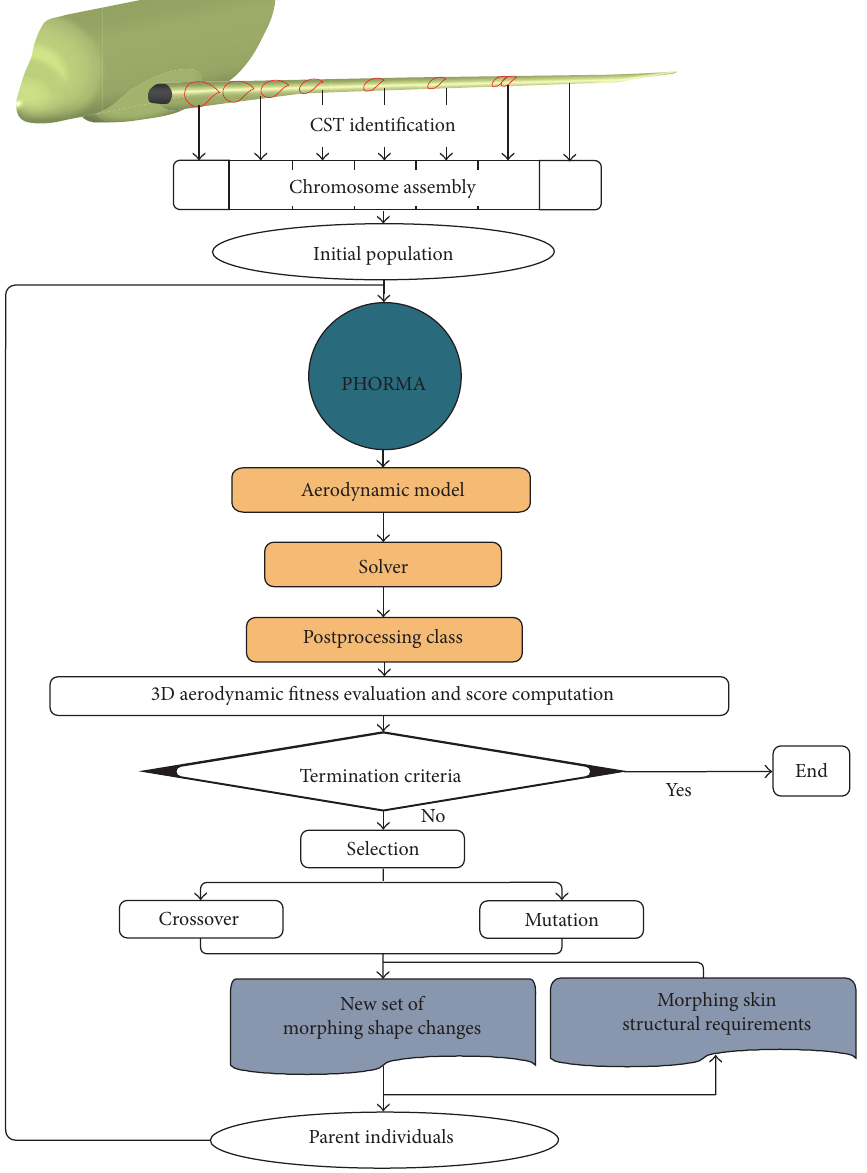
Figure 1: Scheme of the genetic algorithm based on the 3D parametric shape